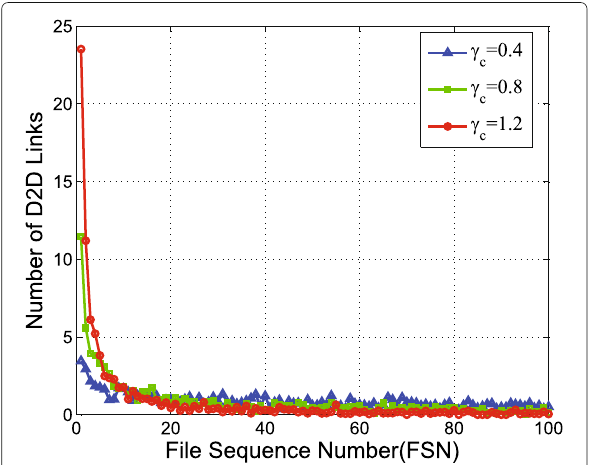
Fig. 4 The average number of D2D links for different File Sequence Number with r =100. This figure shows the number of D2D links established for requesting different files